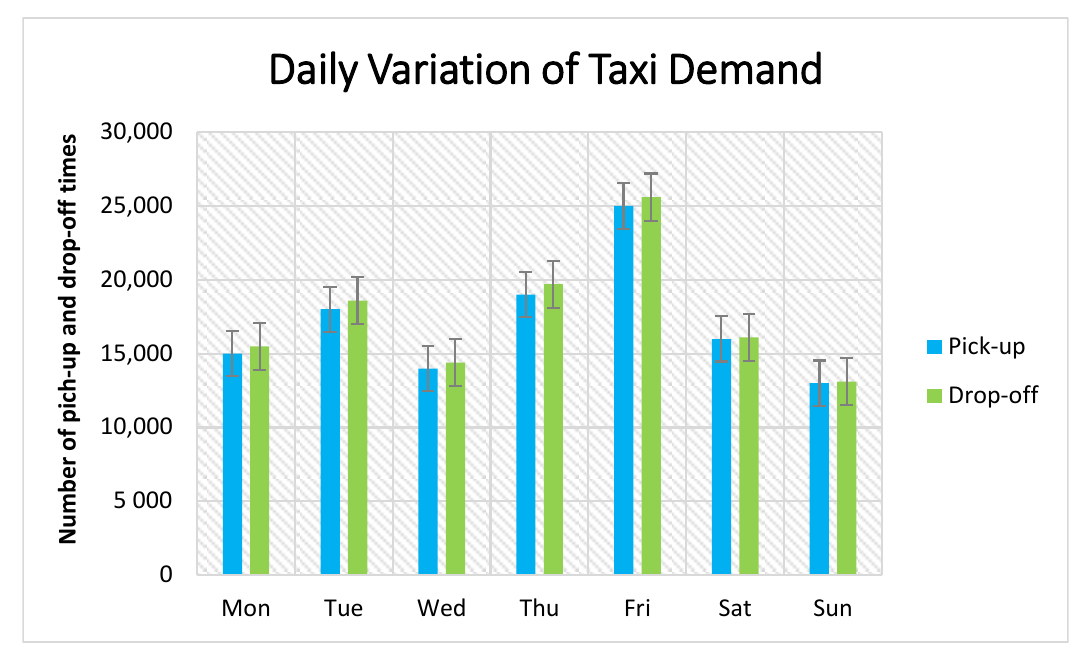
Figure 12. Daily variation of taxi demand.